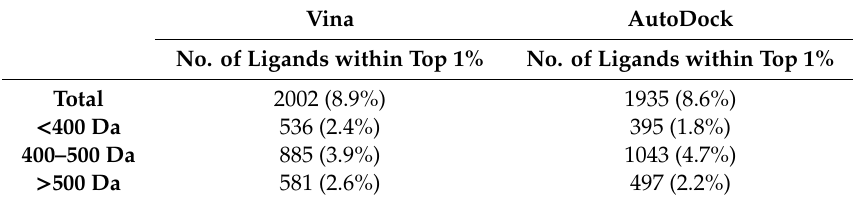
Table 5. Influence of the molecular weight for actives found in the top 1% of the database.